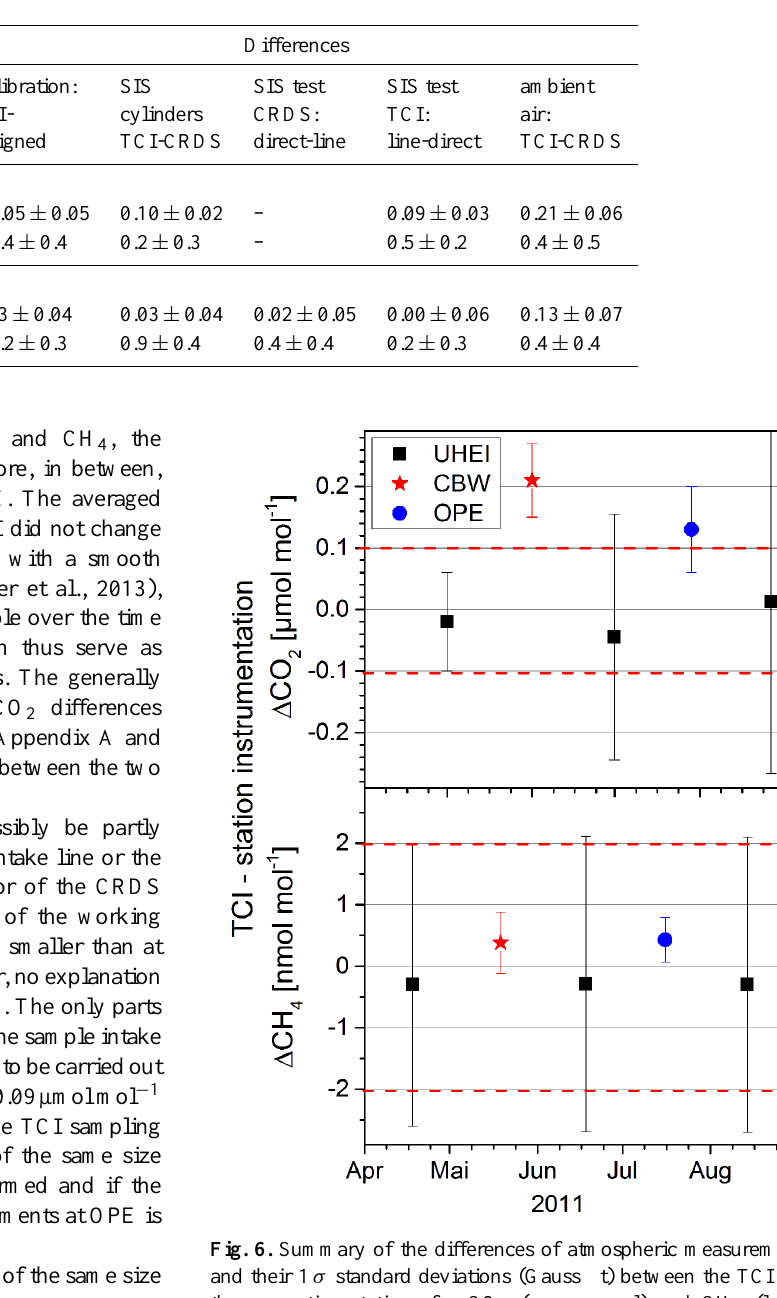
Table 2. Overview of the different comparison tests performed at the ICOS field stations. The representation of the test results is presented with respect to their sign, to be directly comparable to the observed ambient air difference.